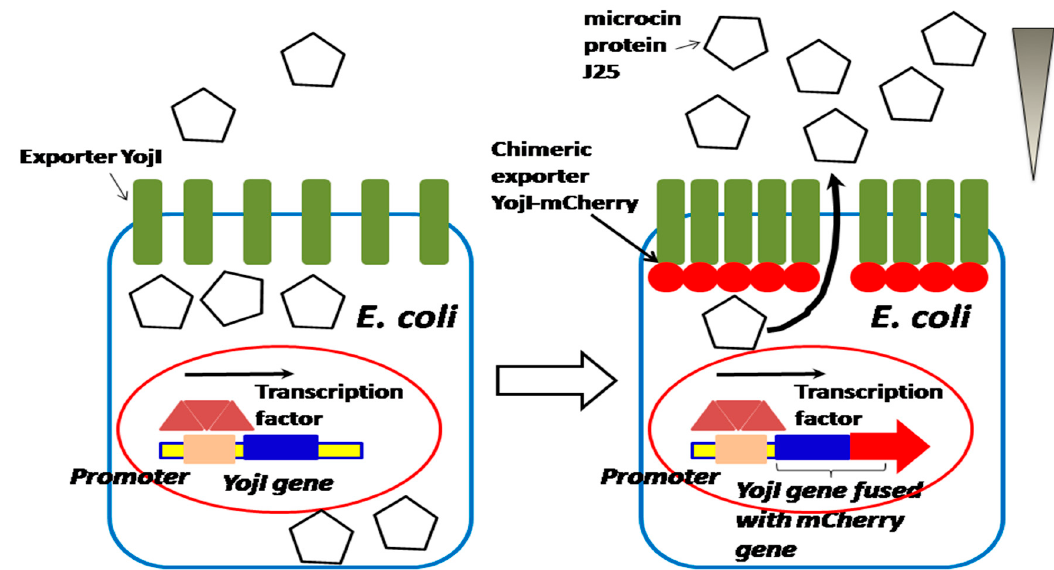
Figure 5. A performance-enhanced promoter is applied for the construction of a chimeric exporter, for the purpose of studying the activity of YojI–mCherry during the export of microcin protein J25.